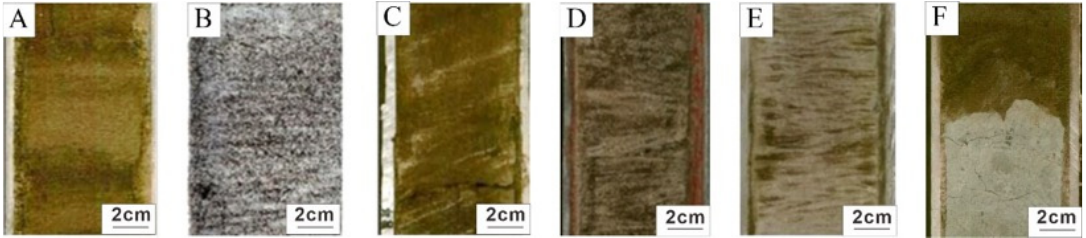
Figure 6. Typical sedimentary structure. ( A ) Graded bedding, PL19 − 3 − H, 1059.2~1059.9 m. ( B ) Parallel bedding, PL25 − 6 − C, 1450.5 m. ( C ) Tabular cross-bedding, PL19 − 3 − F, 1190.5 m. ( D ) Crescent type cross bedding, PL19 − 3 − F, 1181.3 m. ( E ) Sand cross bedding, PL19-3-F, 1166.2 m. ( F ) Erosional basal surface, PL19 − 3 − D, 1364 m.